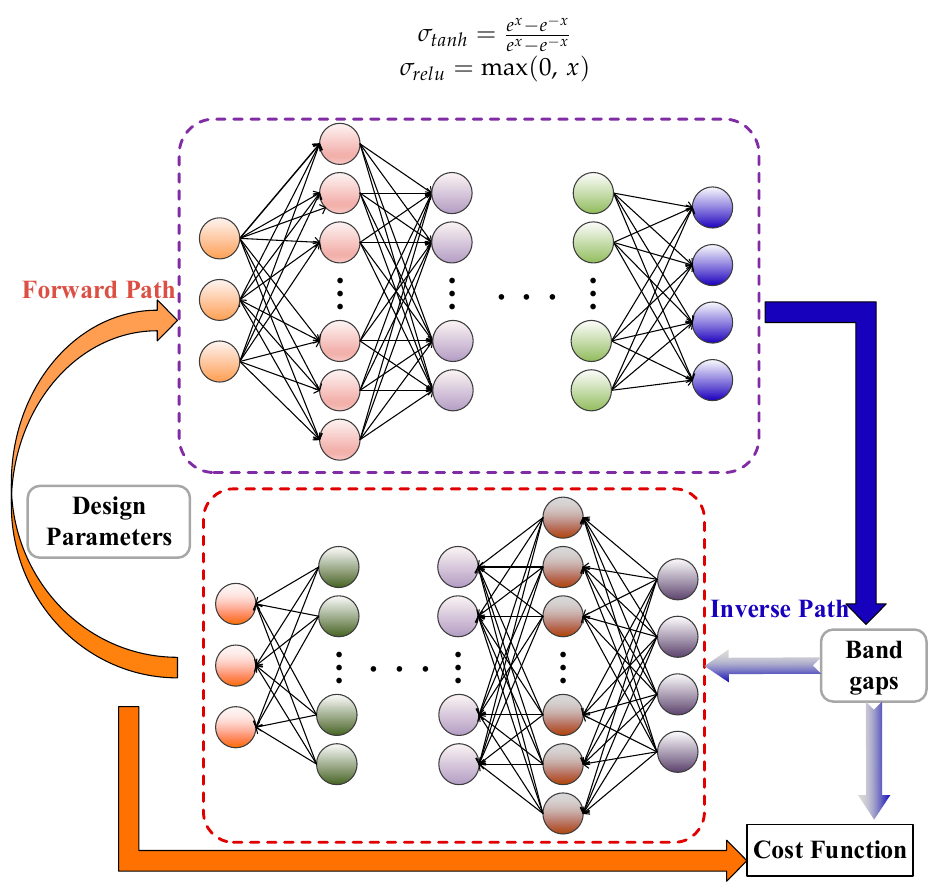
Figure 2. The architecture of the NN model for designing the micro-PnC beam.